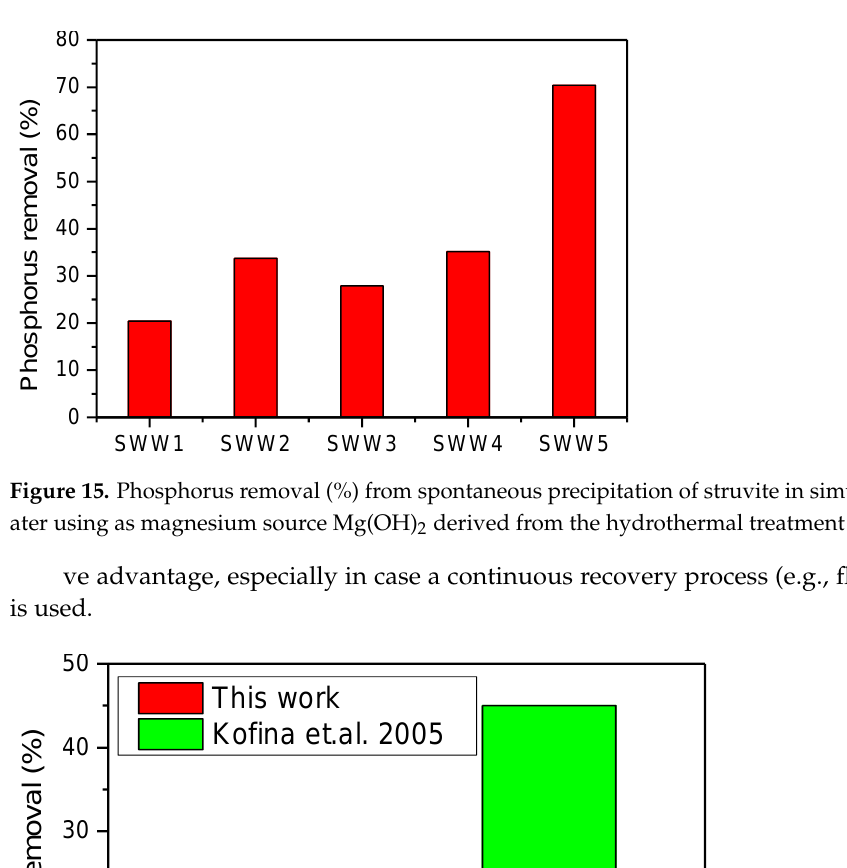
Figure 15. Phosphorus removal (%) from spontaneous precipitation of struvite in simulated wastewater using as magnesium source Mg(OH) 2 derived from the hydrothermal treatment of MgO.